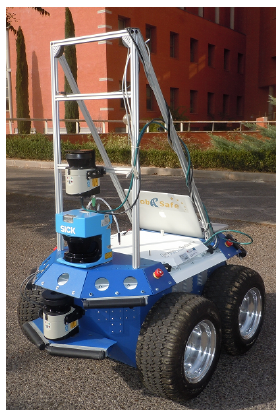
Figure 7. Seekur Jr. used in the